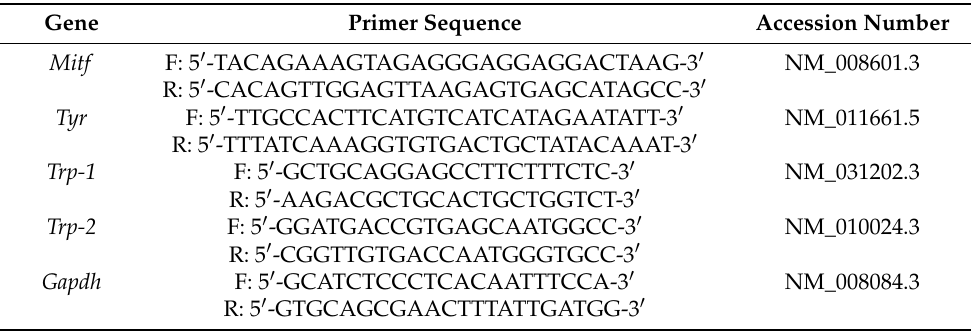
Table 2. Primer sequences of genes used in the